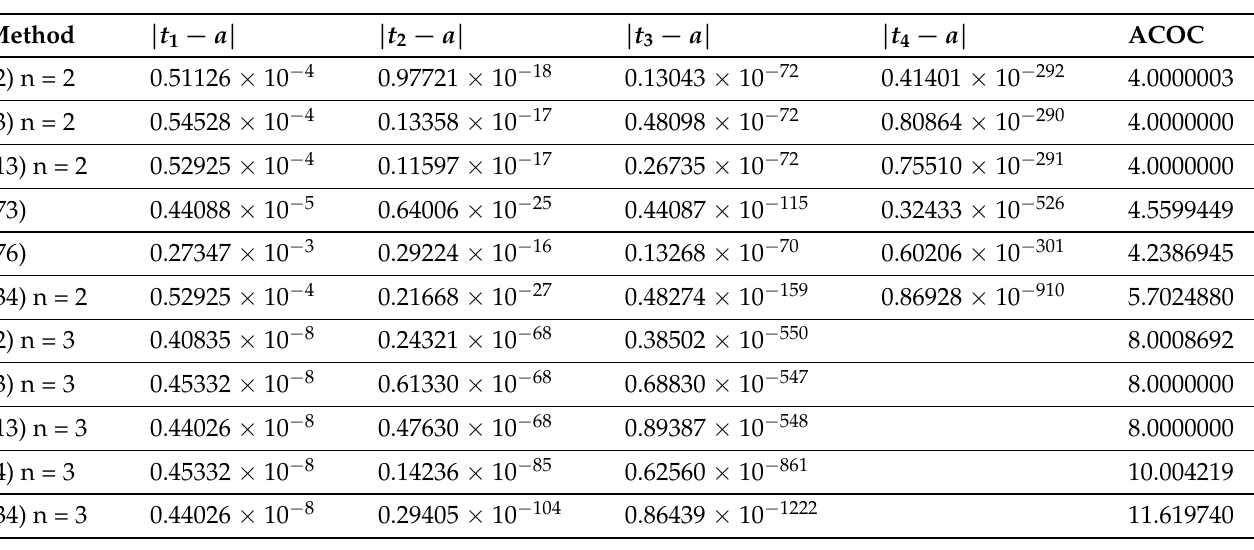
Table 6. Numerical results for f 1 ( t ) .